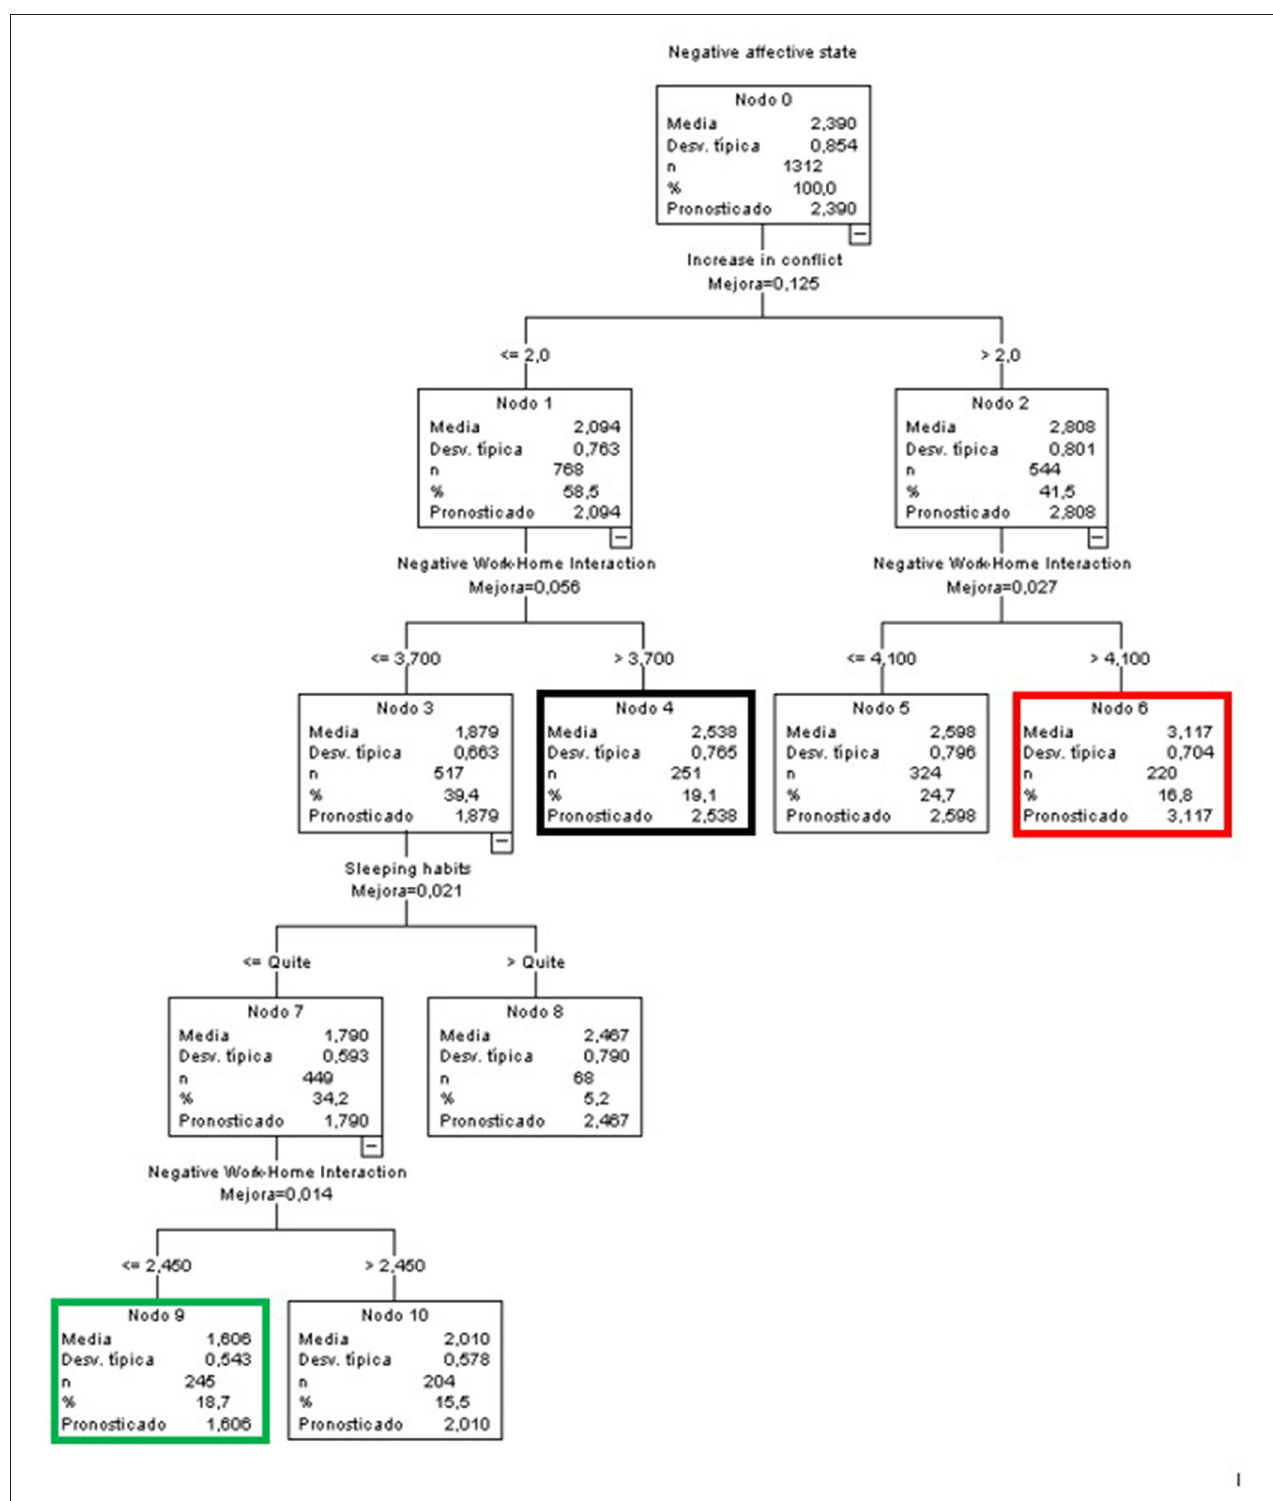
FIGURE 1 | Classificatory tree of negative affective states (Complete sample).